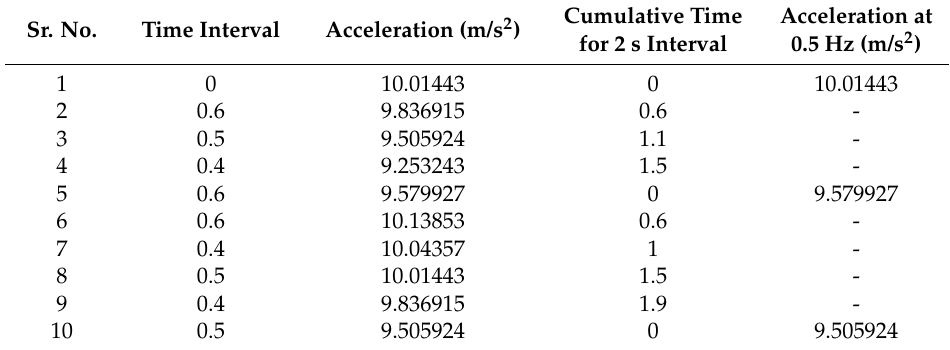
Table 4. Methodology employed for data frequency reduction.